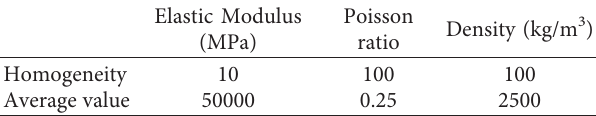
Table 2: Rock material